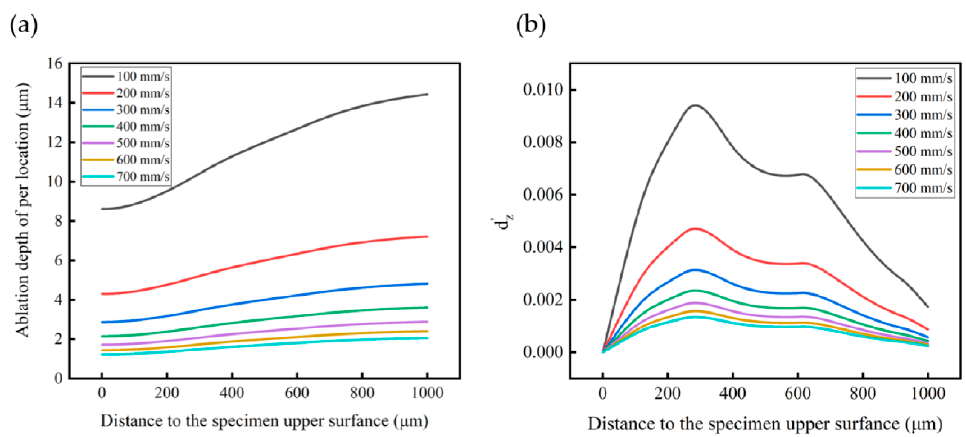
Figure 7. ( a ) Variation of ablation depth of single point with distance from the specimen upper plane; ( b ) Variation of the derivative of the effective ablation depth with distance from the specimen upper plane.